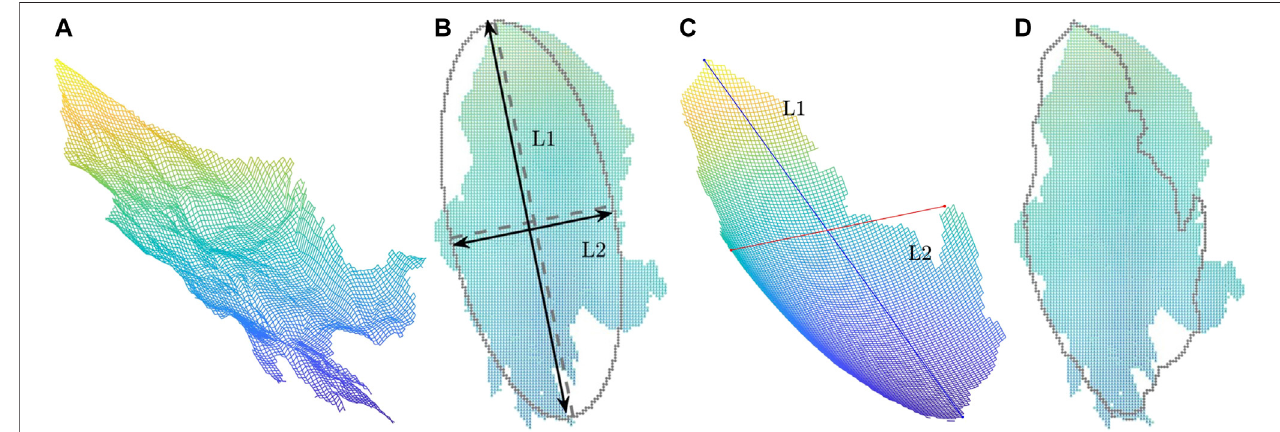
FIGURE 2 | Main scarp area of the 2009 Hsiaolin landslide. (A) The failure surface. (B) Top view of the failure surface and the associated reference ellipse. (C) The constructed ICS. (D) Top view of the ICS (outlined) and failure surface (shaded, used in the SMS method).